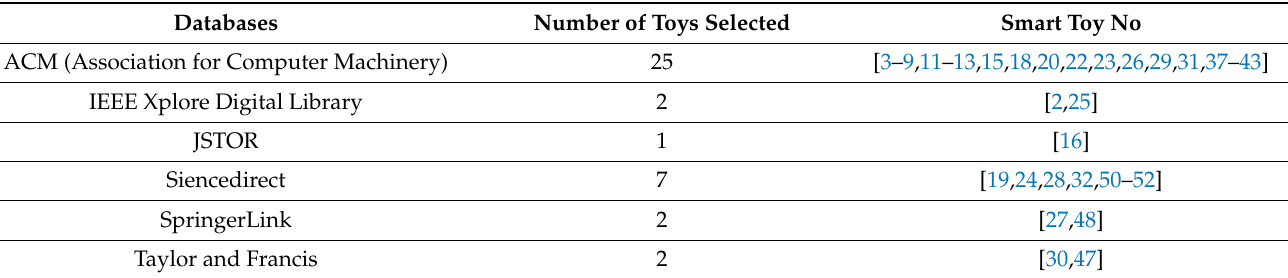
Table 1. Databases for the selection of smart